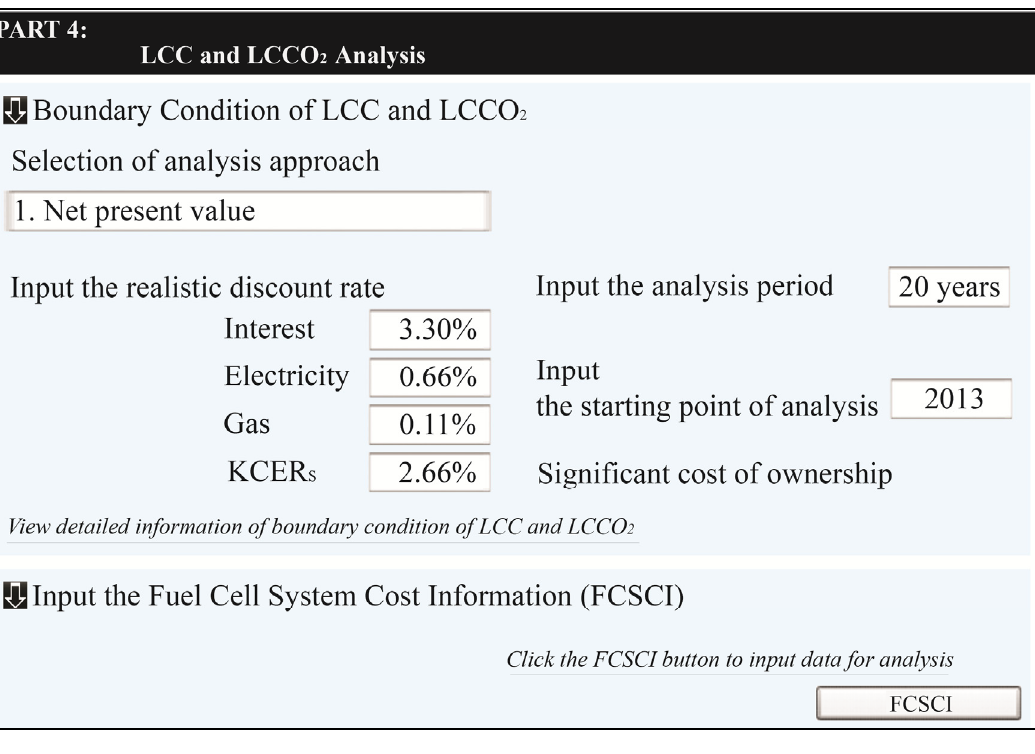
Figure 4. Graphical user interface of Part